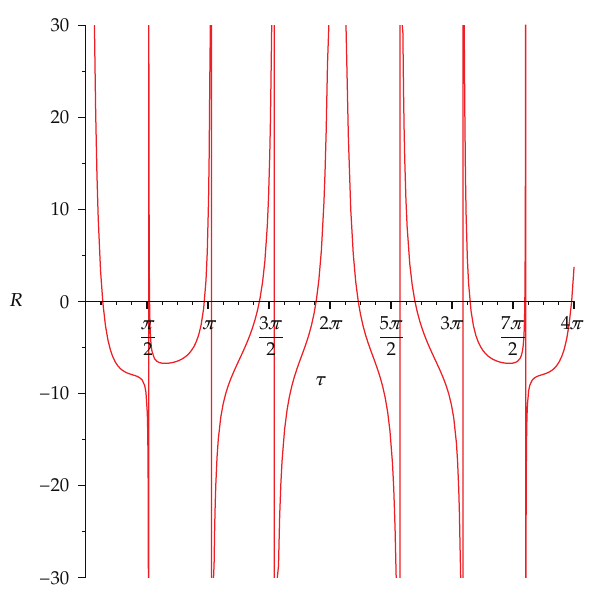
Figure 34: The evolution of the R with respect of the cosmic time τ for (cid:2) 5.29 (cid:3)